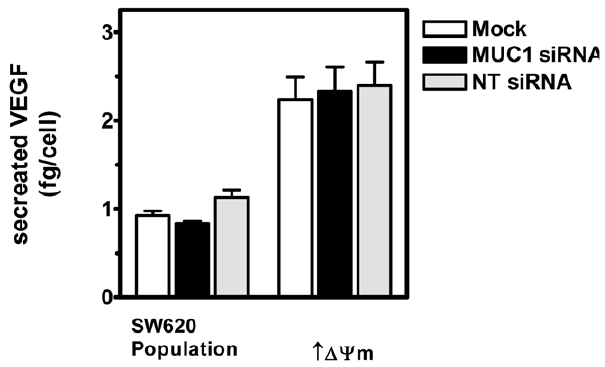
Figure 6. siRNA mediated down-regulation of MUC1 does not affect intrinsic Dy m-linked constitutive hypoxia-independent VEGF secretion. Cells were mock, MUC1- or NT-siRNA transfected and 48 hours later VEGF secretion levels were determined in harvested conditioned tissue culture medium.